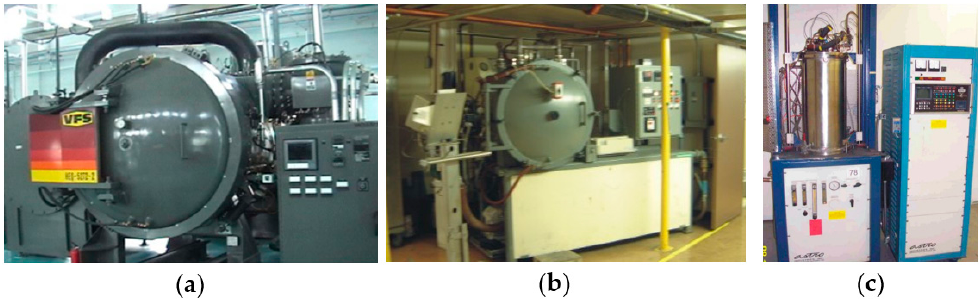
Figure 11. Images of ( a ) a 4-ton vacuum annealer, ( b ) a 200-kg vacuum annealer, and ( c ) a 10-kg flowing-hydrogen annealer. These pictures were taken in Rare-earth Ovonic Metal Hydride Company, Ovonic-BASF, and